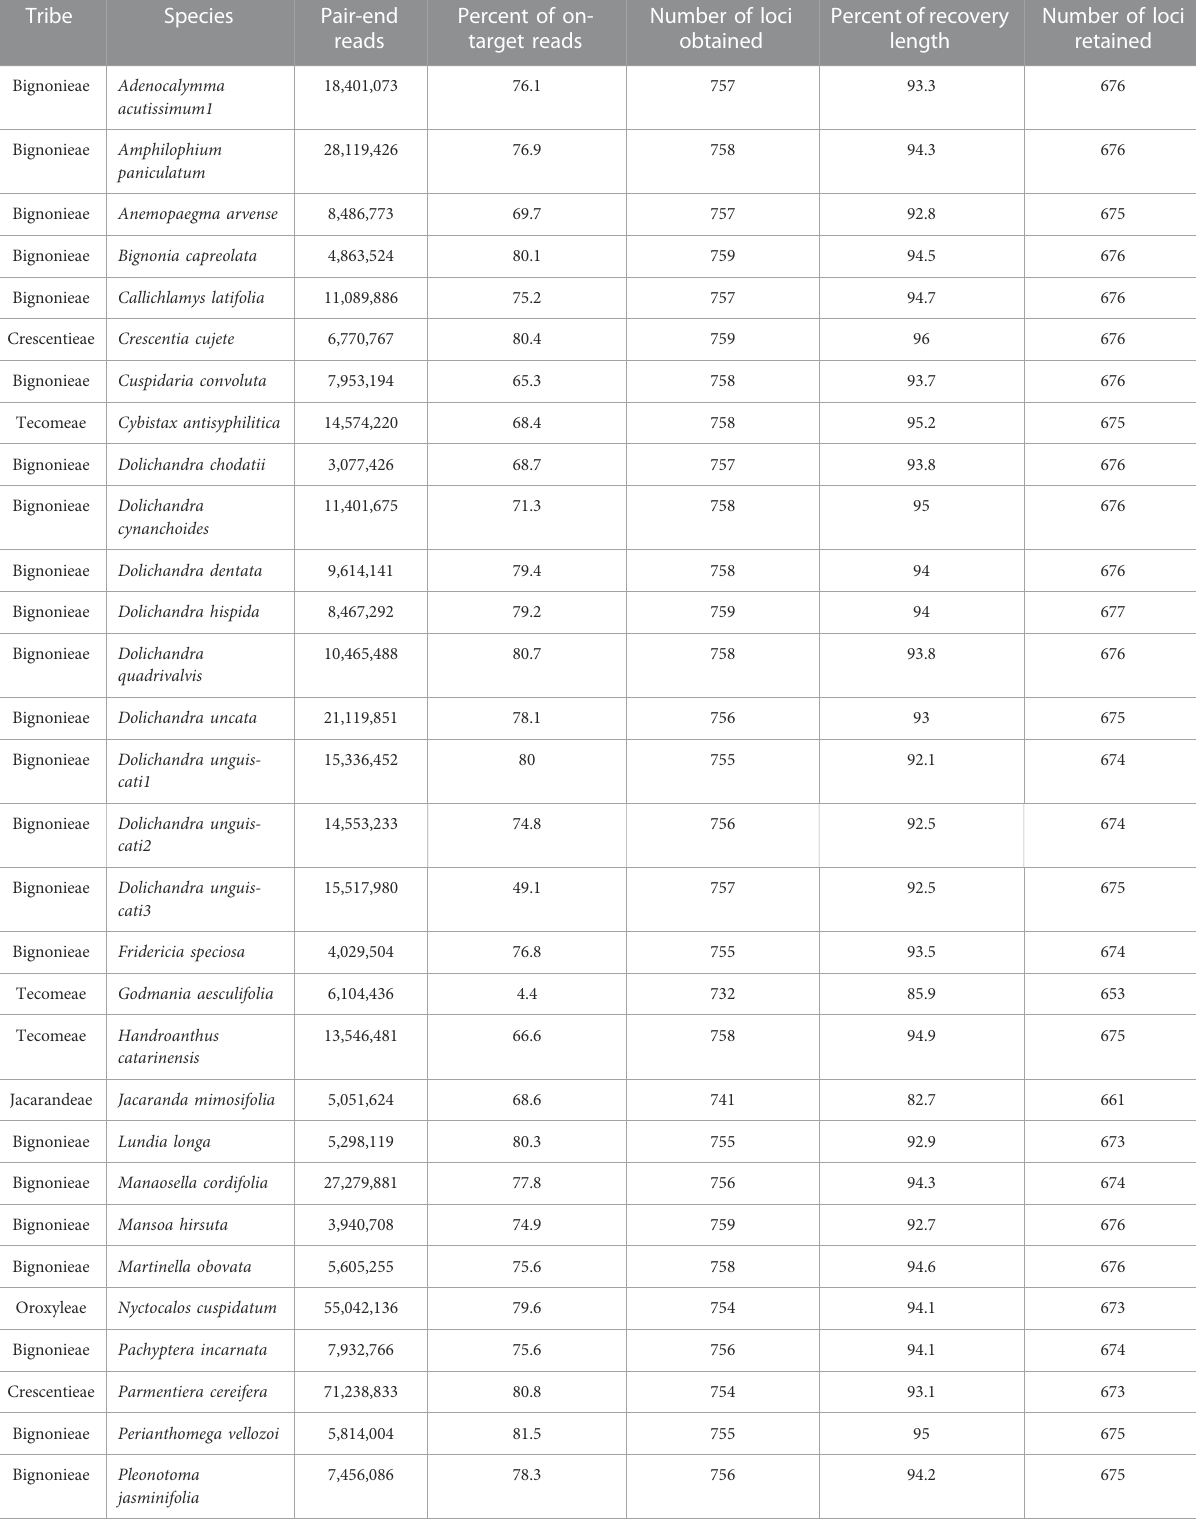
TABLE 1 Summary statistics of sequencing success including the number of raw pair-end reads obtained, percentage of on-target reads, number of loci obtained, percentage of gene recovery, and number of loci retained after paralogs removed. Tribe Species Pair-end